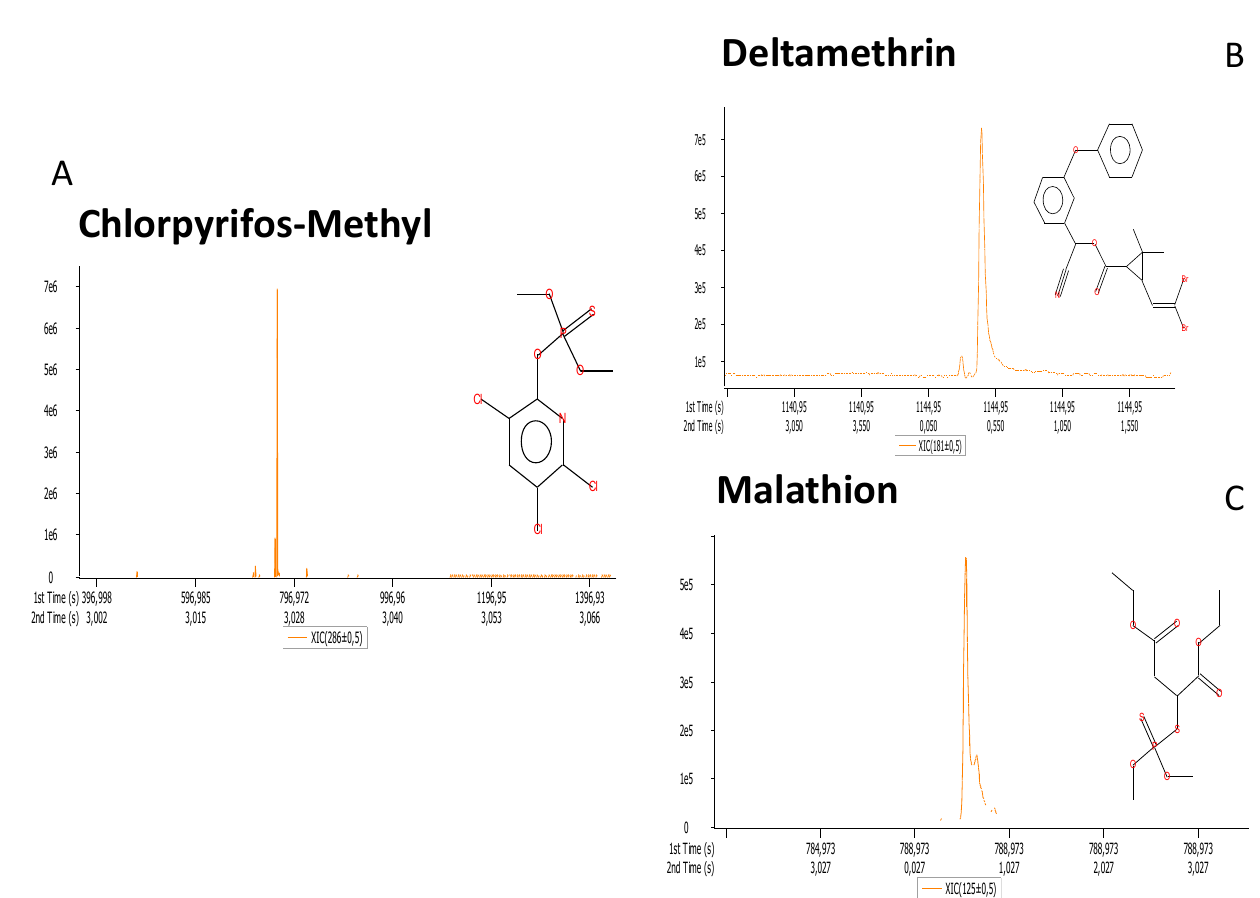
Figure 5. Pesticide residues identified on apple surfaces using the developed method: chlorpyrifos- methyl ( A ), deltamethrin ( B ), and malathion ( C ).